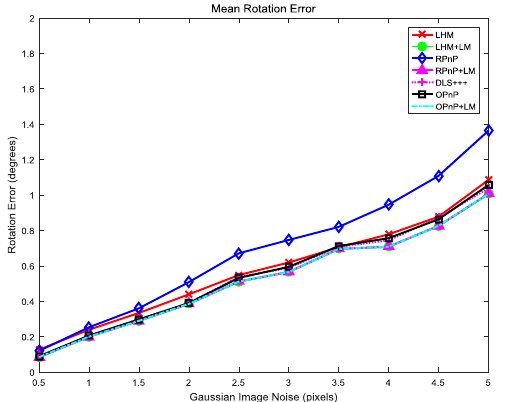
Figure 5. Mean rotation error w.r.t. varying noise levels